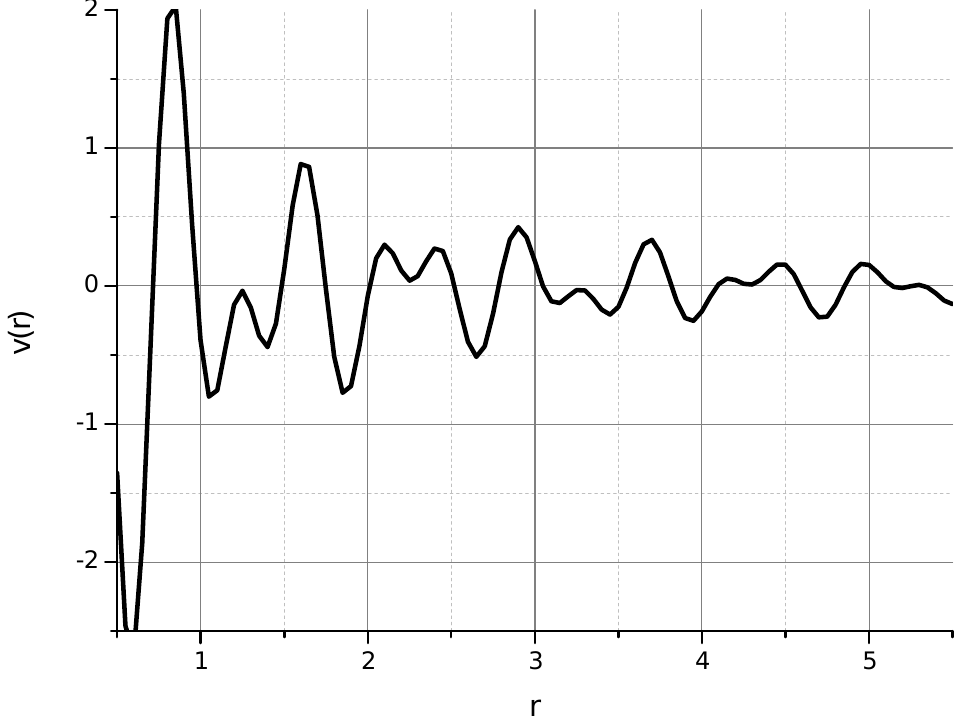
Figure 1. Qualitative representation of a static potential, which is the sum of two elementary potentials and µ ± with complex parameters µ ± 2 1